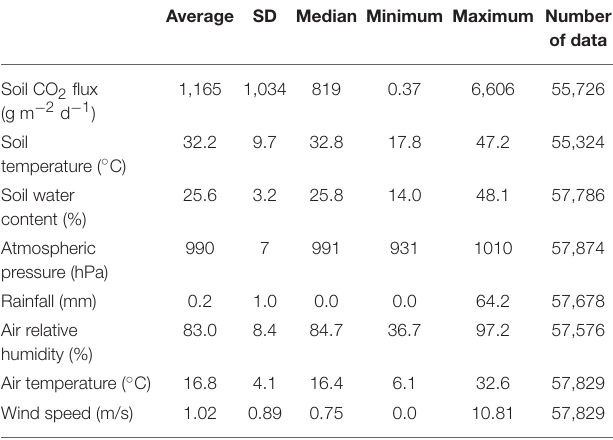
TABLE 1 | Descriptive statistics of the data acquired in